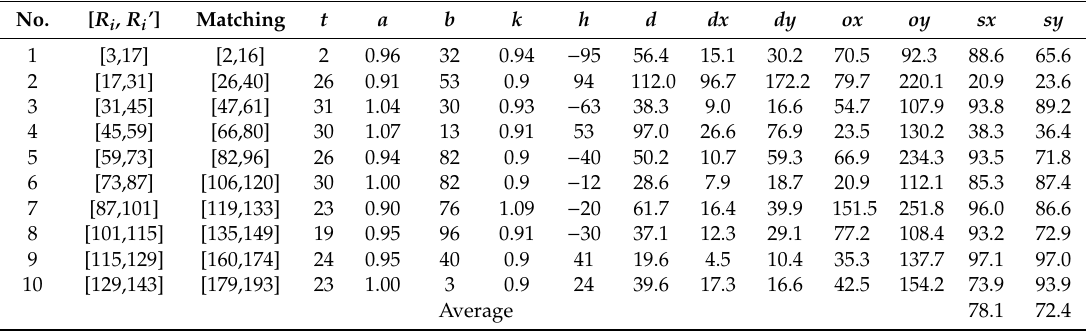
Table 2. Results of segmentation matching between a pair of genuine and forged signature curves ( K = 10).